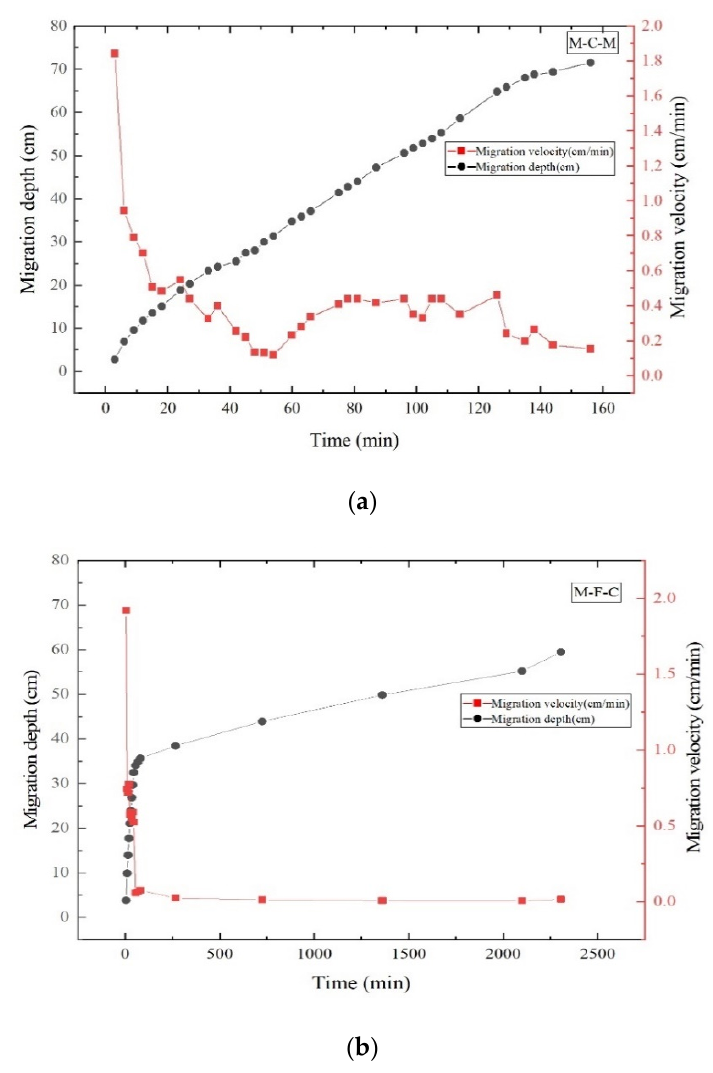
Figure 5. Variation of longitudinal migration depth and migration rate of LNAPL with time in the M-C-M tank( a ) and M-F-C tank( b ) (before entering the third layer of media).